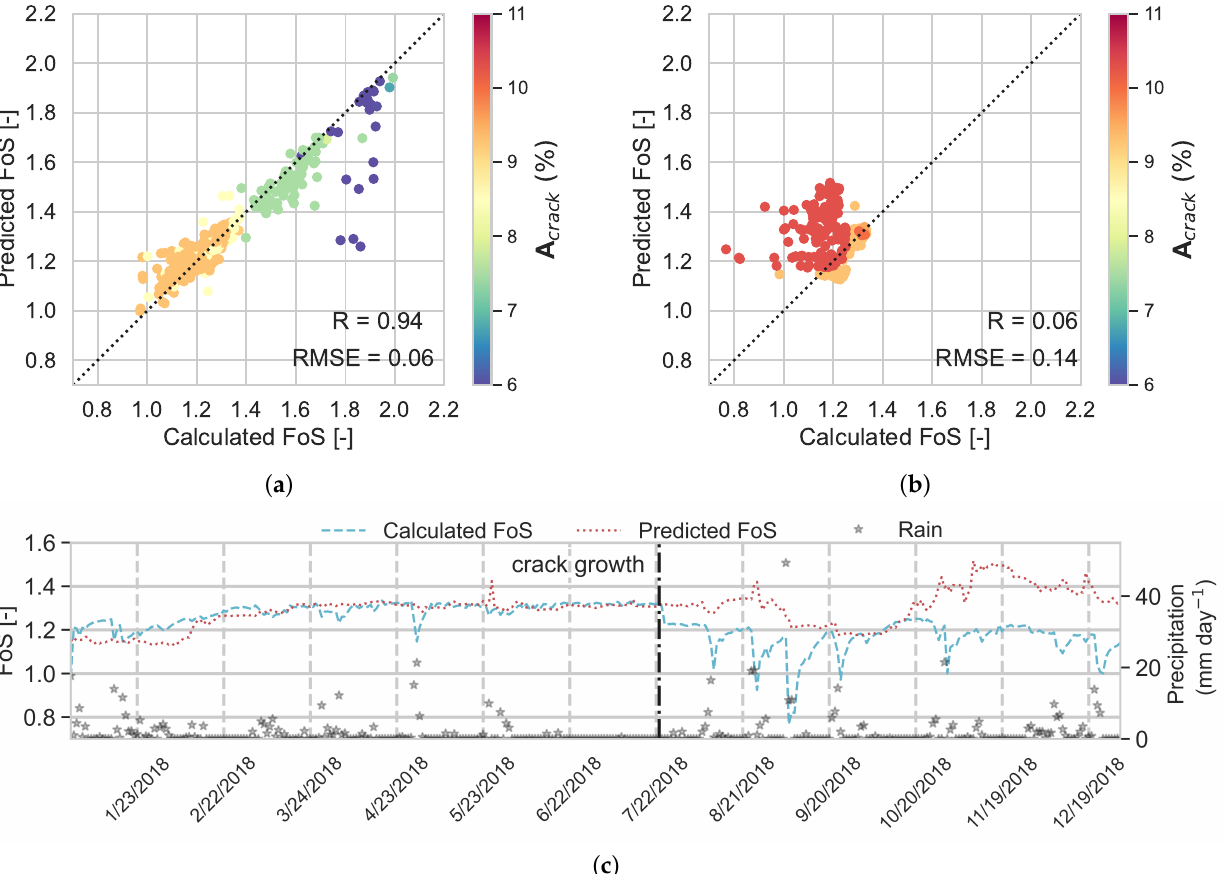
Figure 12. RF stp ,15 d model performance, over ( a ) the testing data set and ( b ) the evaluation data set, and ( c ) time series of predicted and calculated FoS in the evaluation data set (year